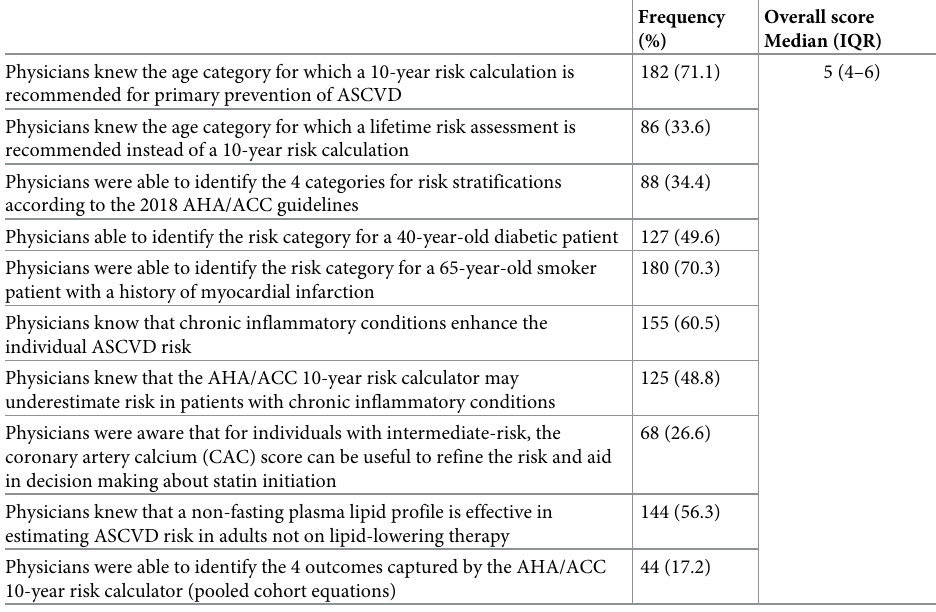
Table 3. Physicians’ knowledge about ASCVD risk assessment before statin therapy